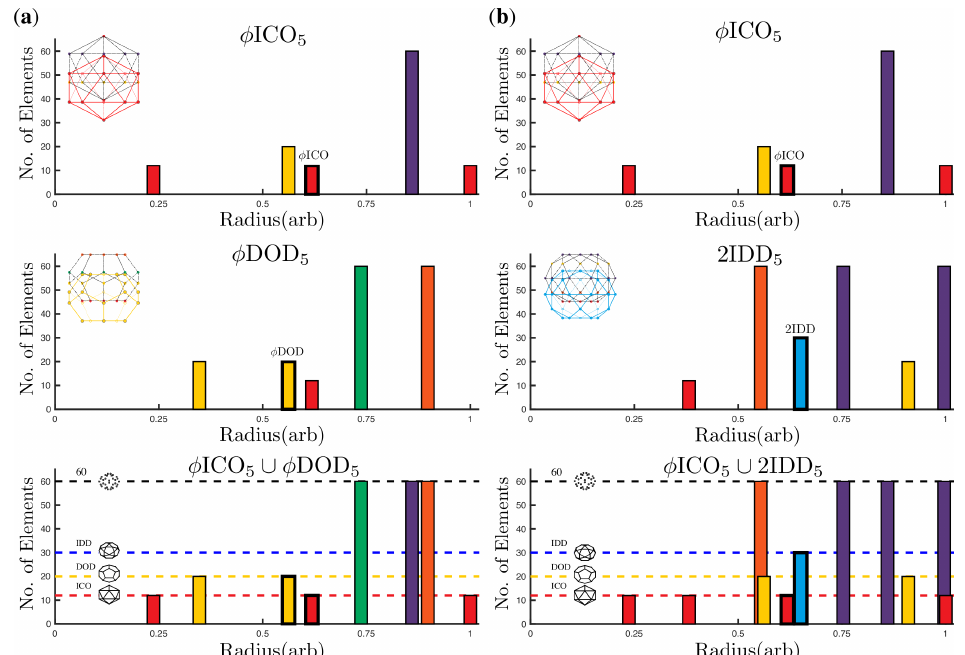
Figure 7. Here we examine two ways to form double point arrays with φ ICO 5 . As before, the base polyhedra are outlined in bold. In ( a ) we examine the formation of φ ICO 5 ∪ φ DOD 5 which adds points above the icosahedral envelope of φ ICO 5 and could be used to locate a site for surface modification of the capsid. The cardinality of φ ICO 5 and φ DOD 5 is 116 and 172 respectively (Table 2); however each of these point arrays respectively generate the base of the other array, reducing the cardinality from 288 points to 256 points, with 8 radial levels, rather than 10. We also see the formation of ( b ) φ ICO 5 ∪ 2IDD 5 which adds surface points near the same radial level as the original gauge points of φ ICO 5 . The cardinality of 2IDD 5 is 242 and none of the points overlap φ ICO 5 . Therefore, the total cardinality of the double point array is 358 and the number of radial levels is 11. Double base point arrays can be used in a variety of applications, e.g., they can provide a more complete radial description of a capsid, indicating geometric constraints on all proteins, or they could provide locations where ligands or decoration proteins could be added to meet these new conditions, or even suggest precisely where internal drugs should be placed to not disrupt the stability of the